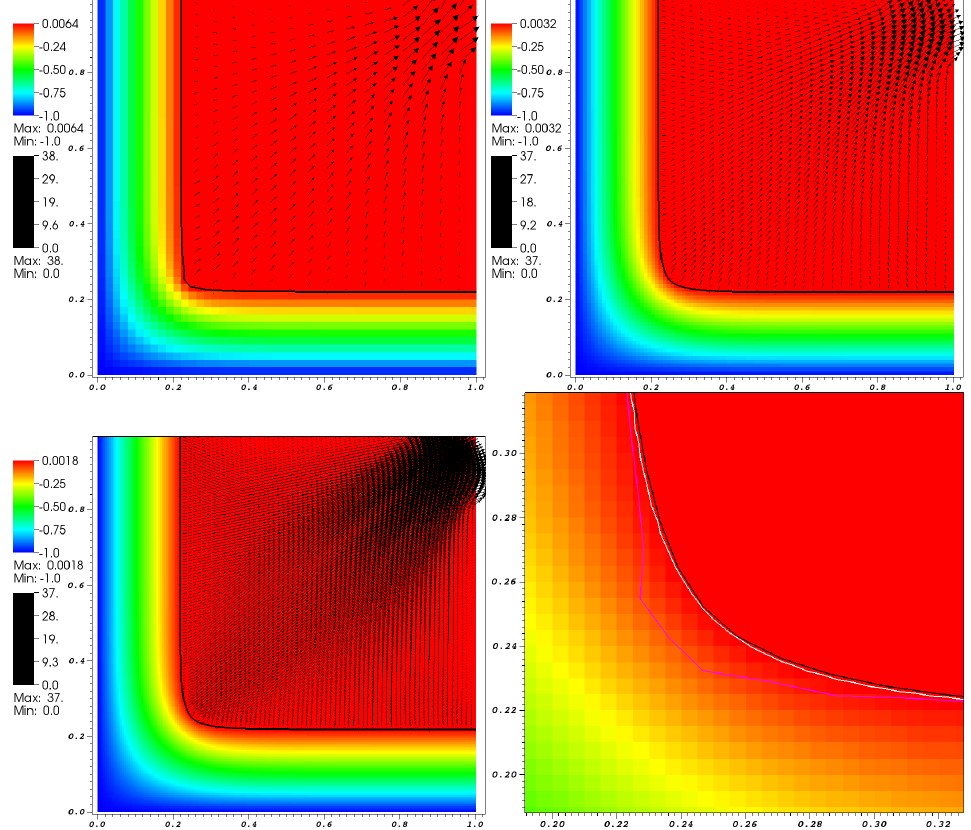
Figure 9. Two-dimensional corner Stefan-like test case—time t = 0.045—Convergence in space with a coarse mesh ( top left ), intermediate mesh ( top right ), fine mesh ( bottom left ) and Convergence comparison ( bottom right )—In color, the temperature profile—Black line representing the interface— Black arrows representing the fluid velocity—Comparison of interfaces at the corner for each fine (white), intermediate (black) and coarse mesh